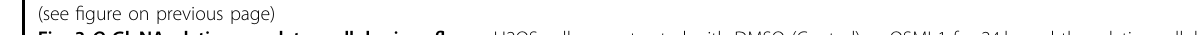
Fig. 3 O -GlcNAcylation regulates cellular iron fl ux. a U2OS cells were treated with DMSO (Control) or OSMI-1 for 24 h, and the relative cellular labile iron levels were assessed using Calcein-AM. b U2OS cells were treated as indicated for 24 h and cell lysates were subjected to immunoblotting with antibodies against IRP2 and β -actin. c , d U2OS cells were treated with DMSO (Control) or OSMI-1 for 12 h, and then treated with RSL3 for different time as indicated. The levels of cellular ferrous iron were assessed by fl ow cytometry using FerroOrange ( c ). Then the mean FerroOrange fl uorescence intensity of each cell was quanti fi ed ( d ). e U2OS cells were treated with OSMI-1 or TMG for 24 h, and the cellular ferrous iron levels were assessed by 3D - structured illumination microscopy using FerroOrange. f U2OS cells were treated with OSMI-1 or TMG for 24 h, and the mitochondrial ferrous iron levels were assessed by confocal microscopy using Mito-FerroGreen. g U2OS cells were treated with OSMI-1 or TMG for 24 h, and the mitochondrial ferrous iron levels were assessed by fl ow cytometry using Mito-FerroGreen. Then the mean Mito-FerroGreen fl uorescence intensity of each cell was quanti fi ed. h U2OS cells were treated with DMSO (Control) or OSMI-1 for 12 h, and then induced with RSL3 for different time as indicated. The mitochondrial ferrous iron levels were assessed by fl ow cytometry using Mito-FerroGreen. i U2OS cells were transfected with control or NCOA4 siRNAs for 48 h, and treated with DMSO (Control) or OSMI-1 for 24 h. The mitochondrial ferrous iron levels were assessed by confocal microscopy using Mito-FerroGreen. j U2OS cells were treated as described in i . The mitochondrial ferrous iron levels were assessed by fl ow cytometry using Mito-FerroGreen and then quanti fi ed. Scale bars, 10 μ m. * P < 0.05, ** P < 0.01, **** P < 0.0001. Error bars indicate